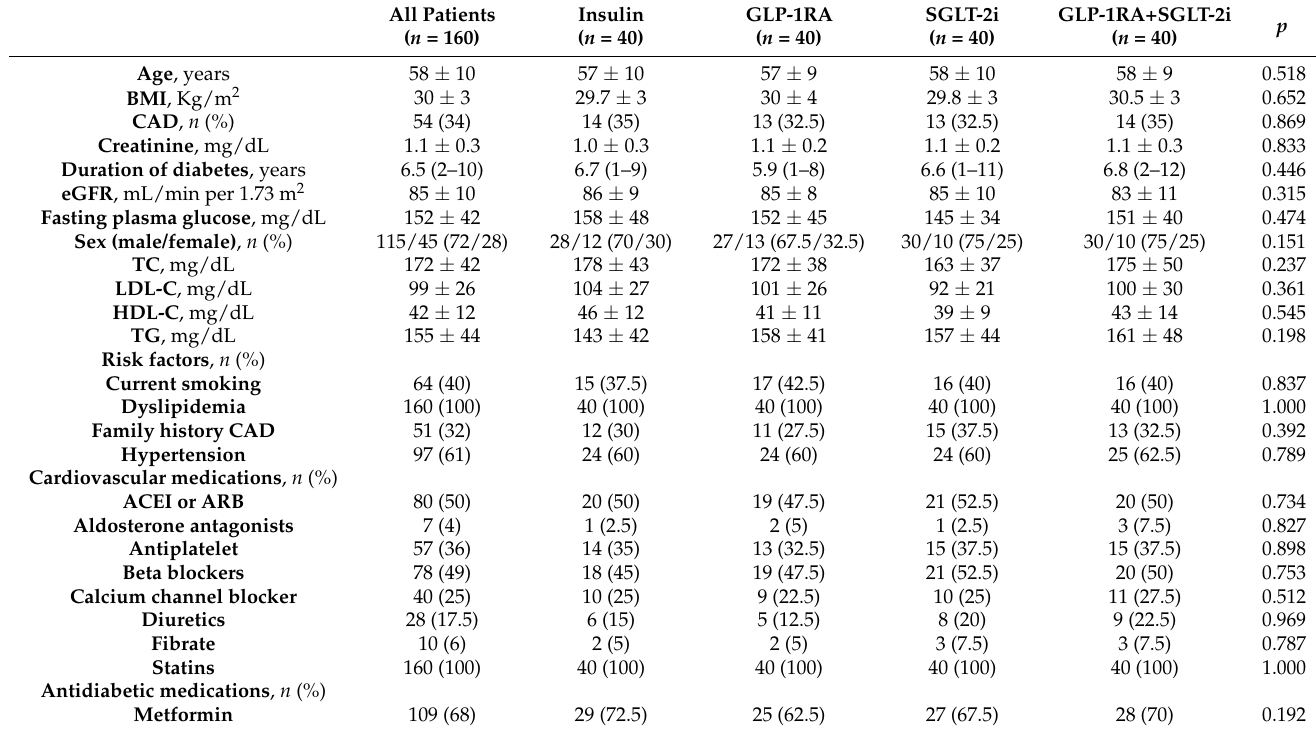
Table 1. Data are presented as absolute frequencies (relative frequencies), mean ± SD, or median (first quartile to third quartile). Scale variables were compared with the paired Student t test. Binary variables were compared with the χ 2 test. ACEI indicates angiotensin-converting enzyme inhibitor; ARB, angiotensin receptor blocker; CAD, coronary artery disease; eGFR, estimated glomerular filtration rate; GLP-1RA, glucagon-like peptide-1 receptor agonists; P , P of model of the ANOVA for comparisons between groups; and SGLT-2i, sodium-glucose cotransporter-2 inhibitors. All Patients Insulin GLP-1RA ( n = 160) ( n = 40) ( n =